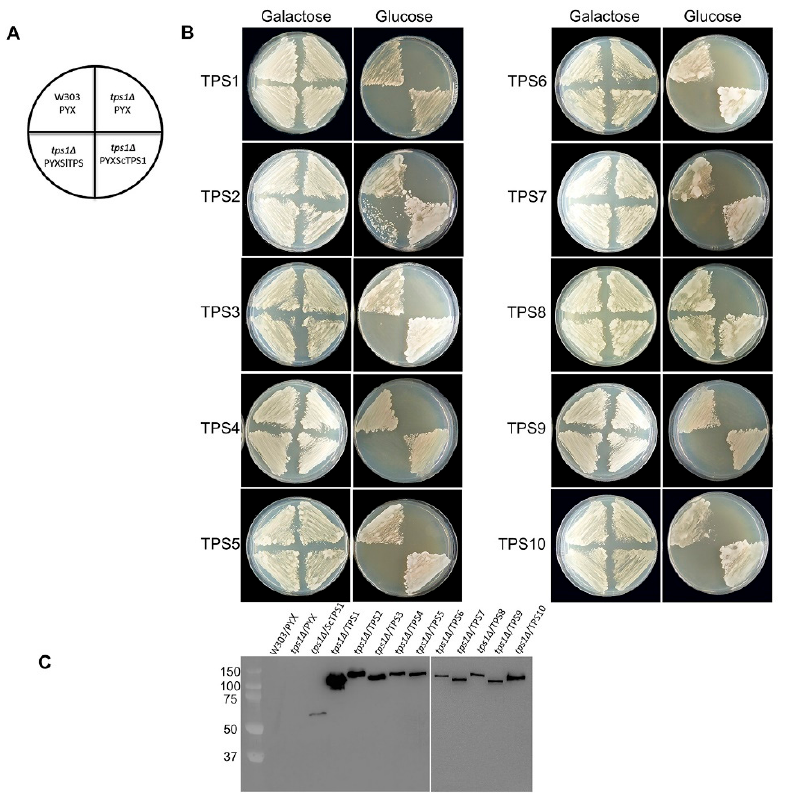
Figure 2. Sl TPS2 and Sl TPS8 display heterologous trehalose-6-P synthase (TPS) activity when grown on glucose plates. ( A ) Layout of growth plates. ( B ) Complementation of the yeast Δ tps1 growth defect on glucose. Growth on galactose served as a control. ( C ) Verification of protein expression in the individual yeast strains by immunoblotting using an anti-HA antibody. The entire experiment has been repeated three times using three independent plates, each with similar results. A representative image is shown here.